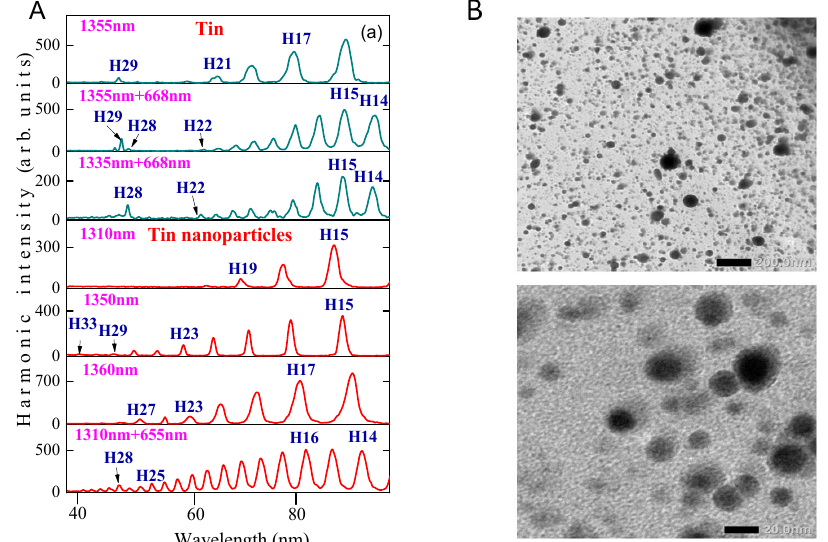
Figure 5. ( A ) Line-outs of harmonic spectra generated in the plasmas produced on the bulk tin and tin NP powder using tunable near-infrared (NIR) driving pulses. First panel from the top: SCP (1355 nm) of the plasma produced on the bulk Sn. Second panel: TCP (1355 nm and 678 nm) of the plasma produced on the bulk Sn. Third panel: TCP (1335 nm and 668 nm) of the plasma produced on the bulk Sn. Fourth panel: SCP (1320 nm) of the plasma produced on the tin NP powder. Fifth panel: SCP (1350 nm) of the plasma produced on the tin NP powder. Sixth panel: SCP (1370 nm) of the plasma produced on the tin NP powder. Seventh panel: TCP (1320 nm and 660 nm) of the plasma produced on the tin NP powder. ( B ) TEM images of deposited tin NPs during ablation of nanoparticle powder at an optimal fluence of HP. The black markers correspond to 200 nm (upper panel) and 20 nm (bottom panel).